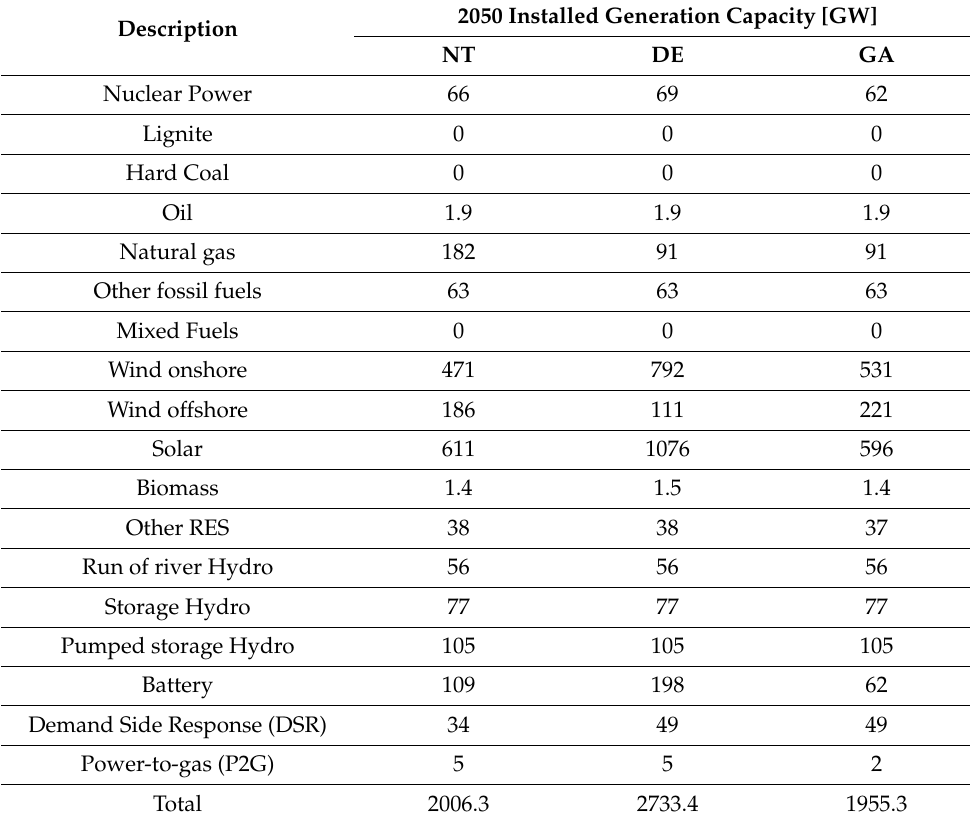
Table 1. 2050 installed capacity by technology for the three FlexPlan